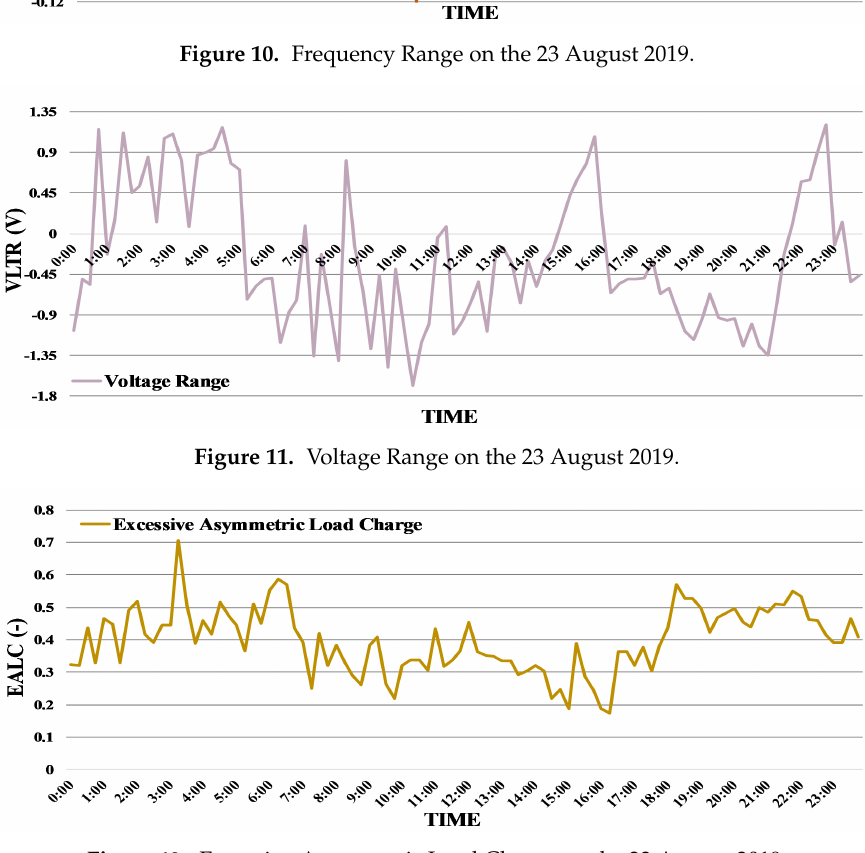
Figure 12. Excessive Asymmetric Load Charge on the 23 August 2019. Table 2. KPIs overview for the studied